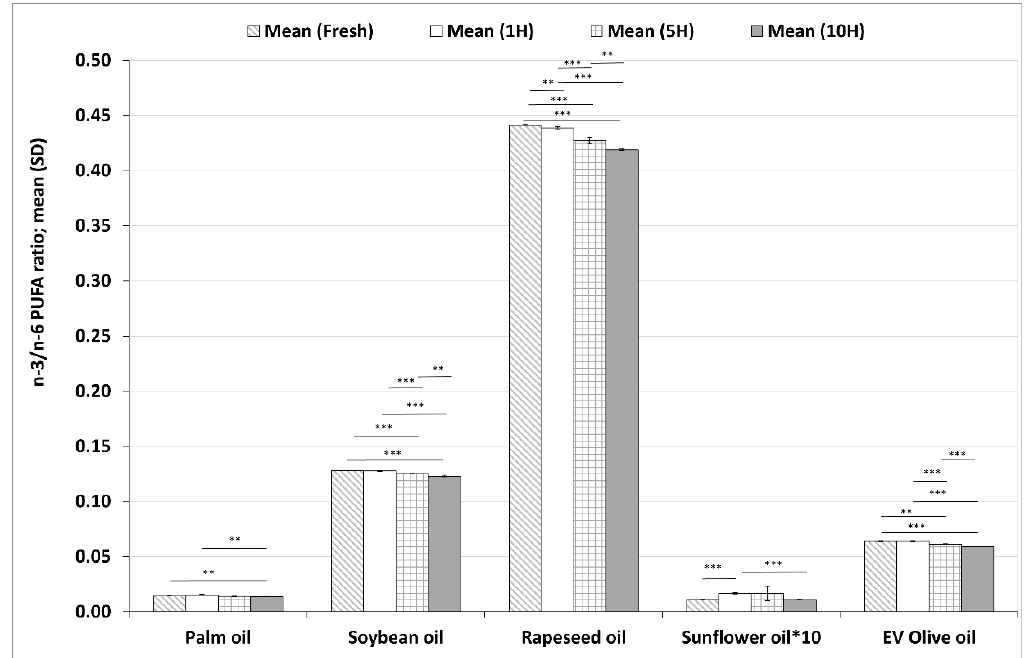
Figure 5. Changes in the n–3/n–6 PUFA ratios in five different plant-based oils in fresh samples and after one (1H), five (5H) and ten heating sequences (10H). Data for sunflower oil are shown at 10x magnification for better visibility. Each column shows the mean (SD) data of six different chromatograms. Asterisks denote statistically significant differences between the different time points in the same oil; *: 0.01 ≤ p < 0.05; **: 0.001 ≤ p < 0.01; ***: p < 0.001. EV olive oil: extra virgin olive oil.